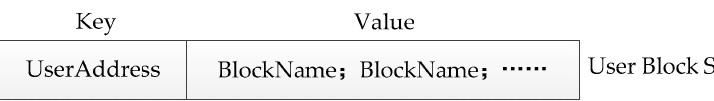
Figure 8. The Data storage structure of “user block collection” in Redis cache.